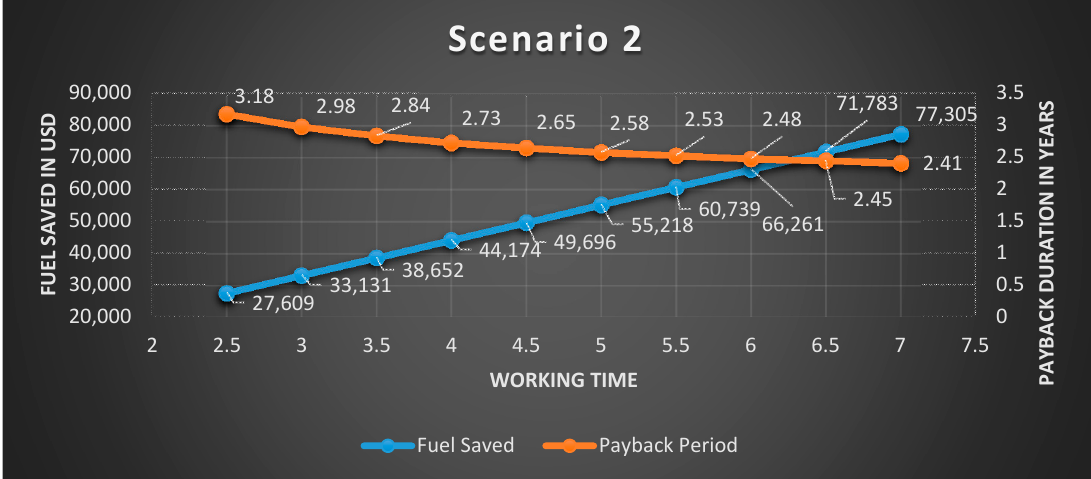
Figure 9. Fuel savings and payback time with operating times for 10%L + 20%L loads. Figure 10 visualizes the figures in Table 3, with an emphasis on the drastic diesel fuel savings scaled on the left axis.